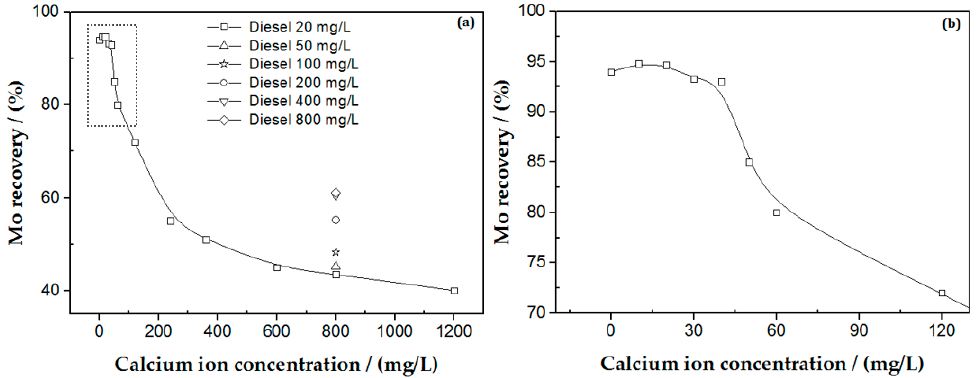
Figure 4. The influence of Ca 2+ concentration on PM flotation at pH 8: ( a ) the original curve, ( b ) the enlargement of the dashed square in the original curve.